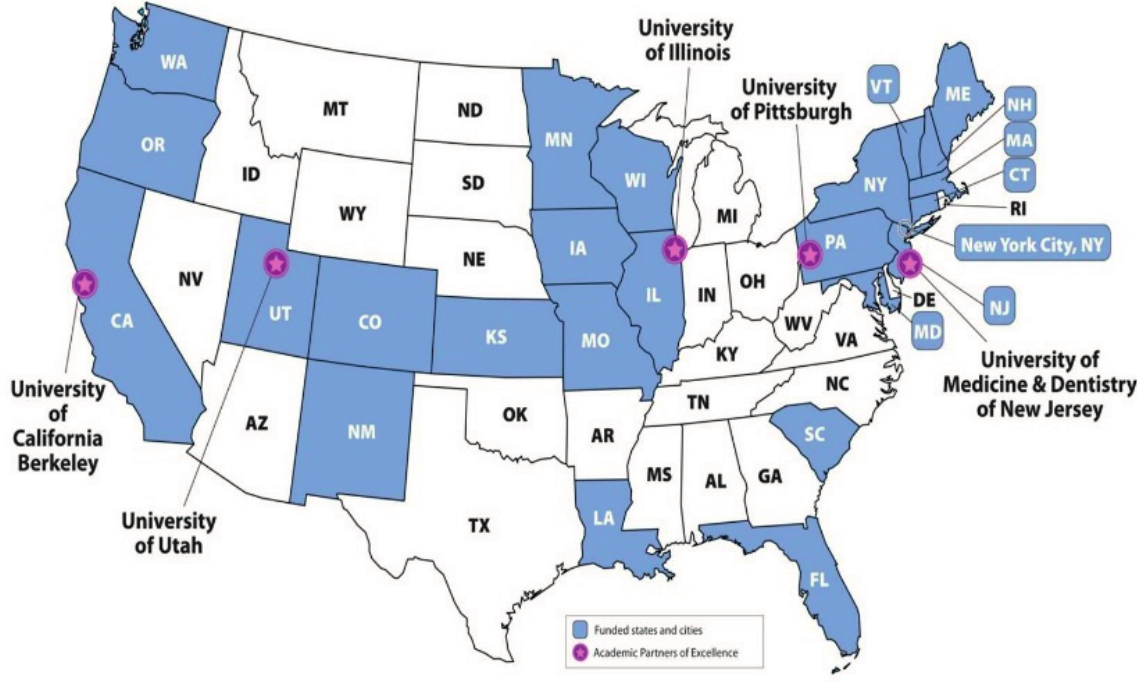
Figure 5 . Current tracking states and academic